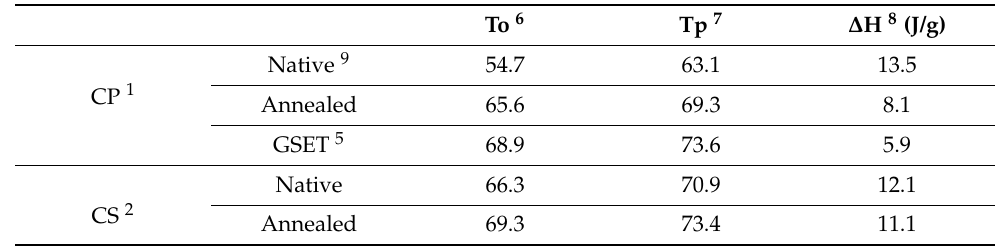
Table 6. The effect of enzyme extract (GSE) on the thermal properties of annealed starches at 60 ◦ C for 60